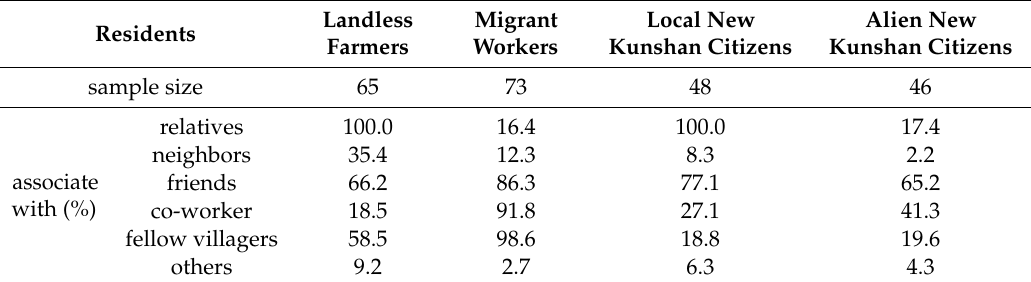
Table 2. Characteristics of interviewees’ social